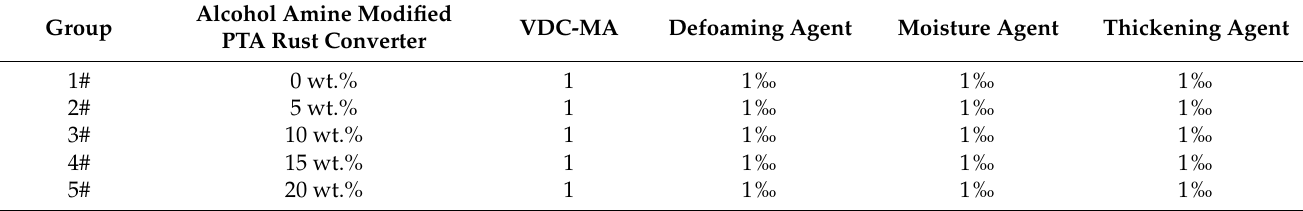
Table 3. The mass ratios of ingredients in waterborne polymer-based